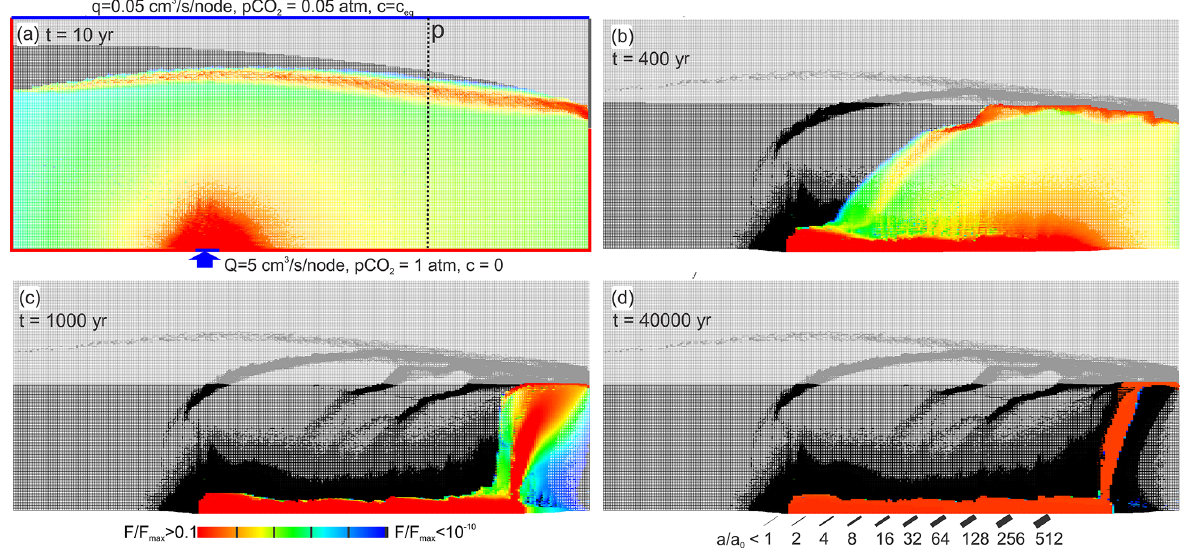
Figure 10. Standard scenario with upwelling water undersaturated with respect to calcite, c in = 0, and input raised to 5cm 3 s − 1 . The red region indicates high rates of fracture